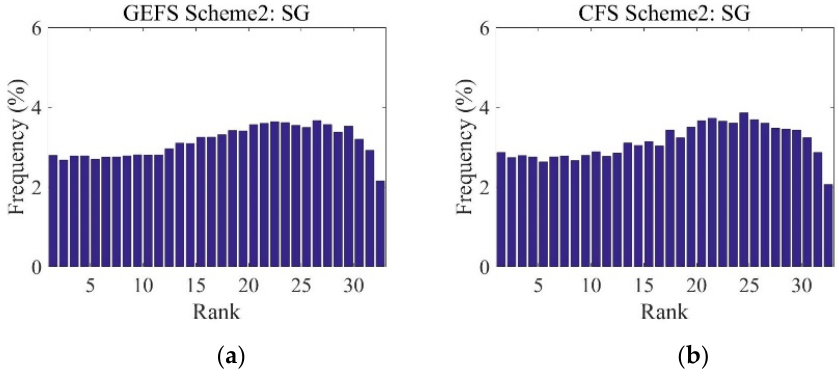
Figure 8. RHs of Shaoguan under the Scheme 2: ( a ) GEFS; and ( b ) CFSv2.